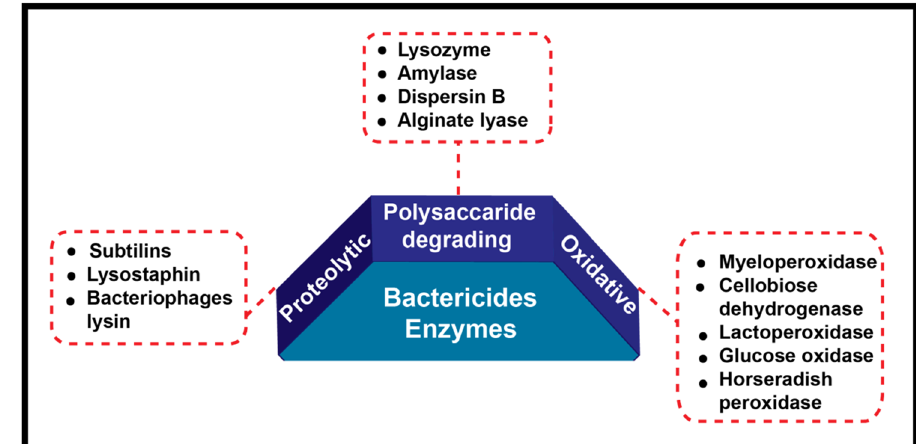
Figure 1: Antimicrobial